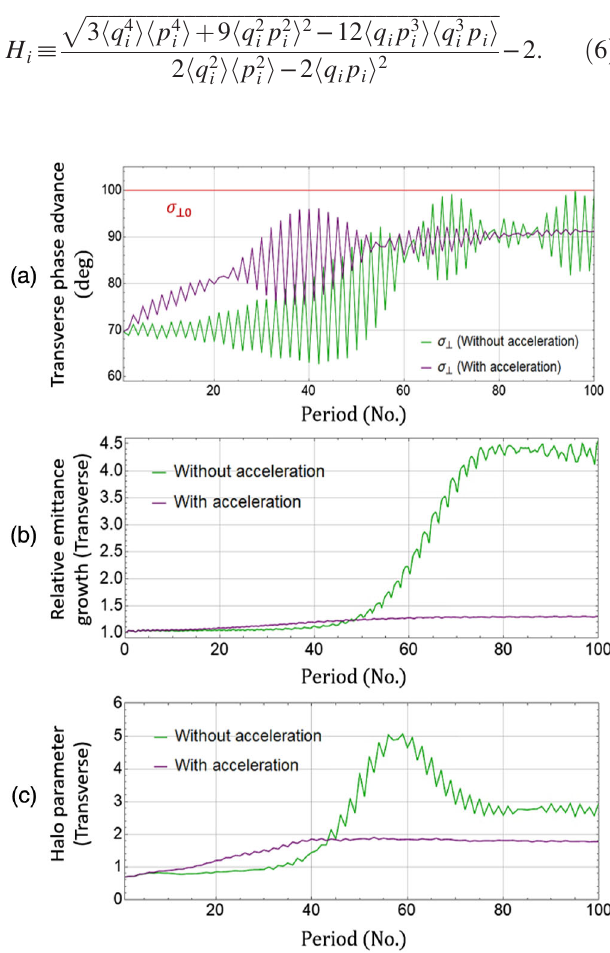
FIG. 6. (a) Transverse phase advances, (b) relative emittance growth, and (c) halo parameter for cases with and without acceleration under the solenoid focusing lattice. The transverse zero-current phase advance is maintained to be constant for σ 100 ° over 100 periods. Envelope instability can be ⊥ 0 ¼ mitigated with a high accelerating gradient (purple lines), which leads to passing through the envelope instability stop band faster than beams without acceleration (green lines). Here, the accel- erating gradient is 5 MV = m, and the beam current is 10